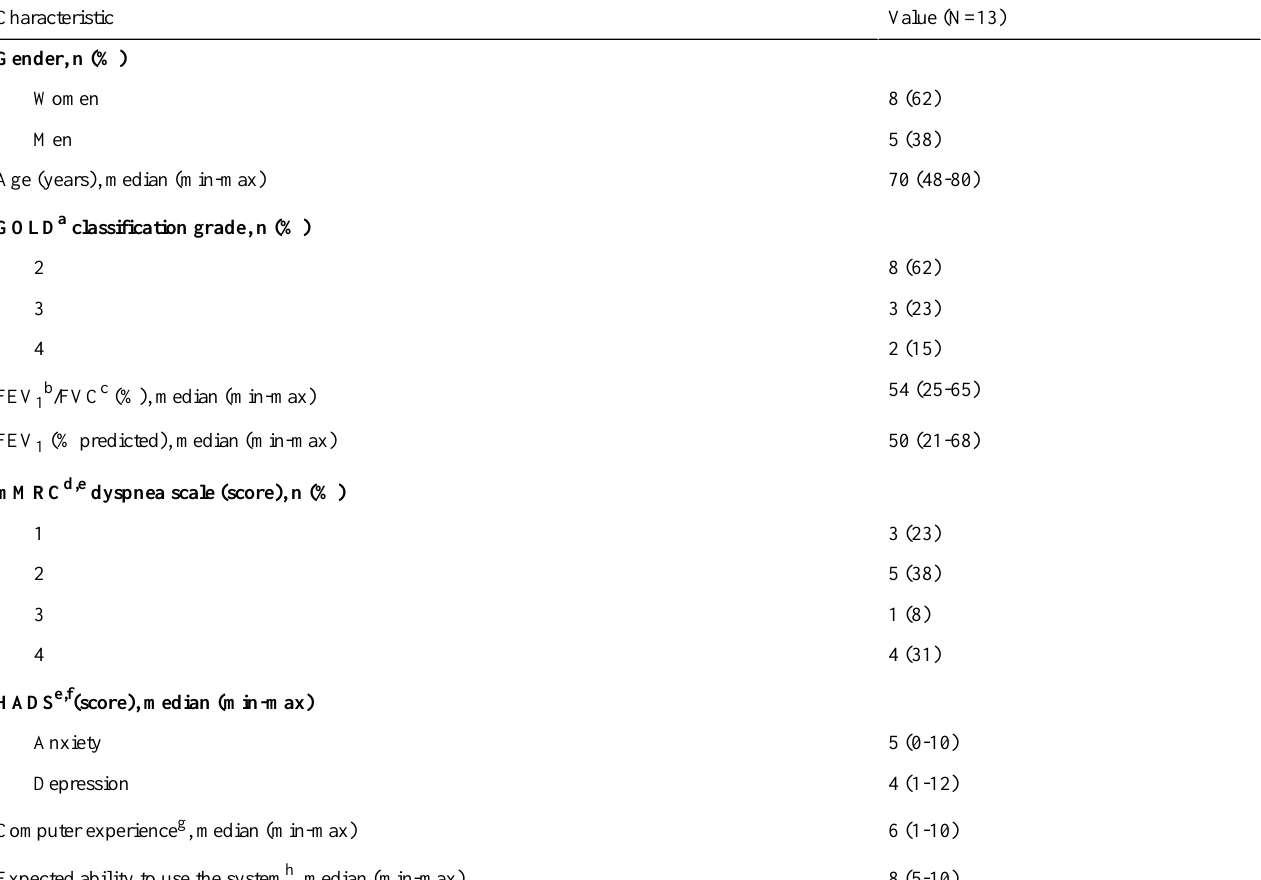
Table 1. Characteristics of participants included in the interview